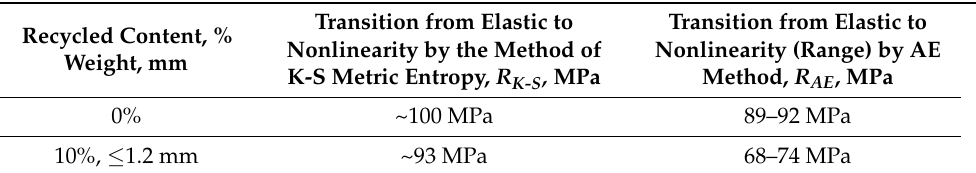
Table 4. Summary of results for analysed samples obtained with the AE method and the K-S metric